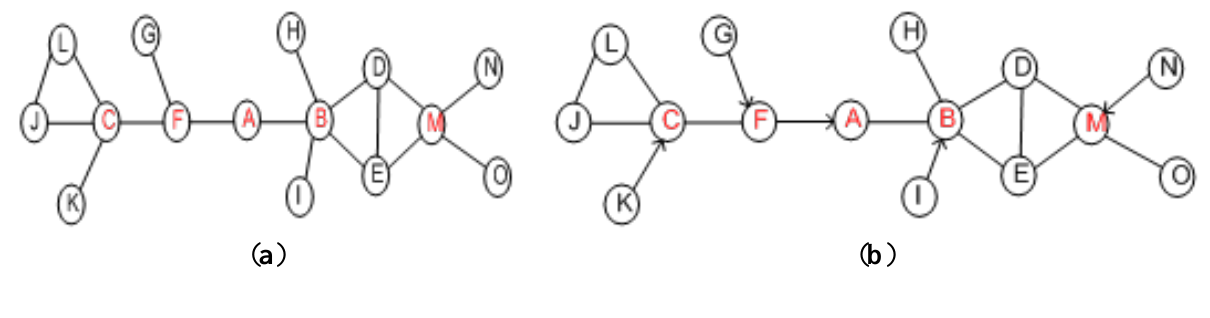
Figure 4. Determine critical nodes and assign backup: ( a ) 1-hop critical/non-critical and ( b ) designate backup using